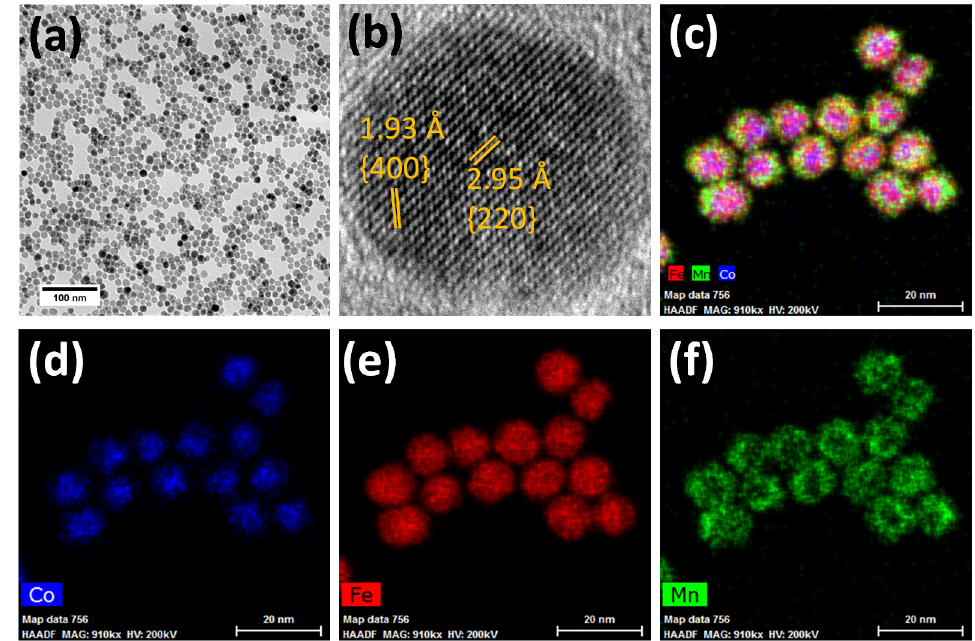
Figure 1. HR-TEM images and STEM-EDX maps across the oleate-capped Co1@Mn MNPs. Panel ( a ) shows a representative view of the sample, panel ( b ) demonstrates a well-crystalline structure of the MNP with lattice fringes and Miller’s indexes. A STEM-EDX joined map is shown in panel ( c ), cobalt, iron, and manganese STEM-EDX maps are presented in panels ( d – f ) respectively. Selected structural and magnetic parameters are visualized in Figure 2, and the original data are summarized in Tables S1 and S2 in the Supplementary Material. It is worth mentioning that all MNPs have quite high and similar values of the M s, which points to the overall high crystallinity of MNPs